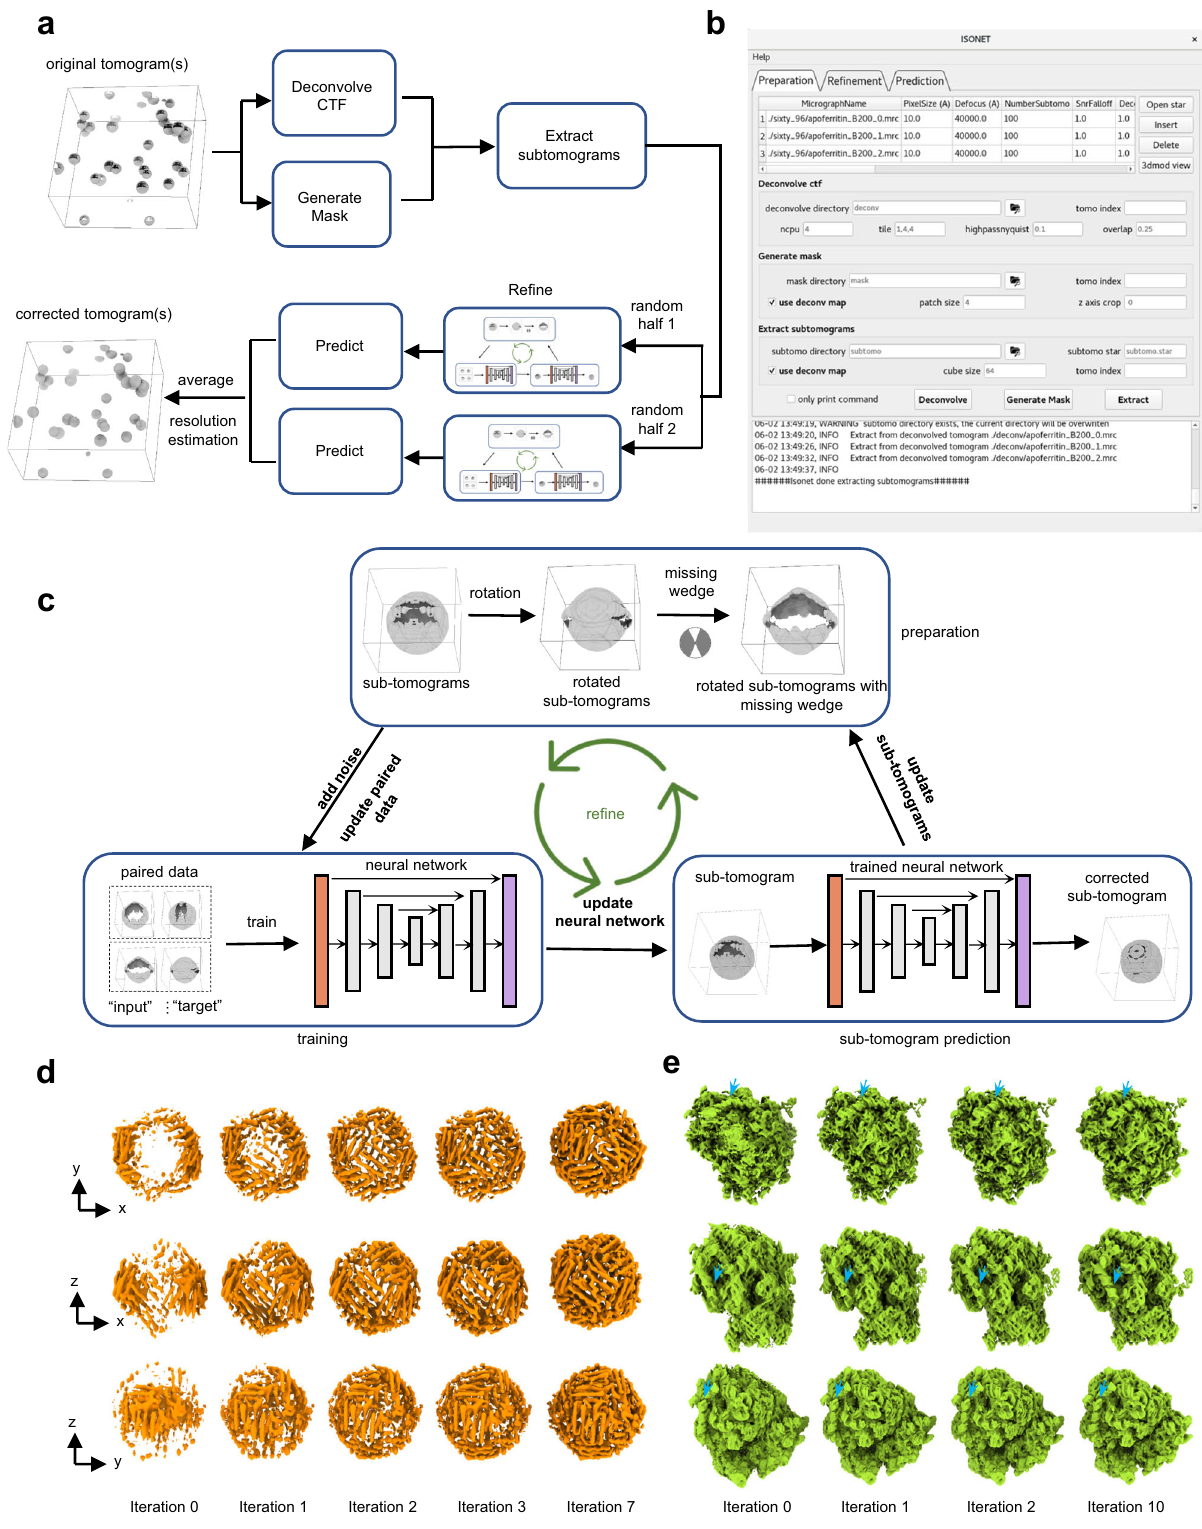
Fig.1|Principleandwork fl owofIsoNet.a Work fl owoftheIsoNetsoftware. b GUI of IsoNet. c Illustration of Re fi ne step: First, subtomograms are rotated and then applied with additional missing-wedge artifacts along other directions (e.g., YZ axis) to produce paired data for training. Second, the paired data is used to train a neuralnetworkwithU-netarchitecture.Third,thetrainedneuralnetworkisapplied to the extracted subtomograms to produce missing-wedge corrected